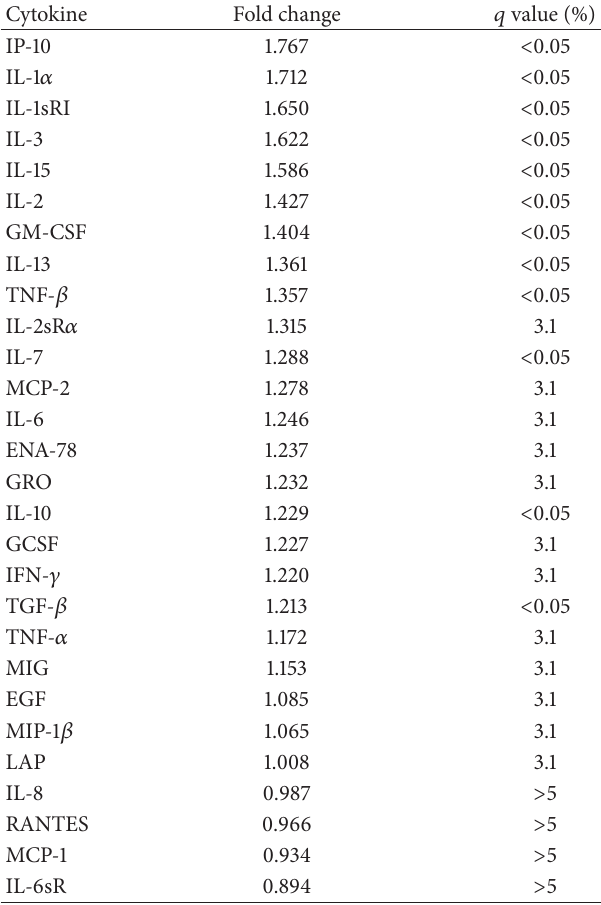
Table 1: Twenty-eight cytokines measurable in serum of uranium